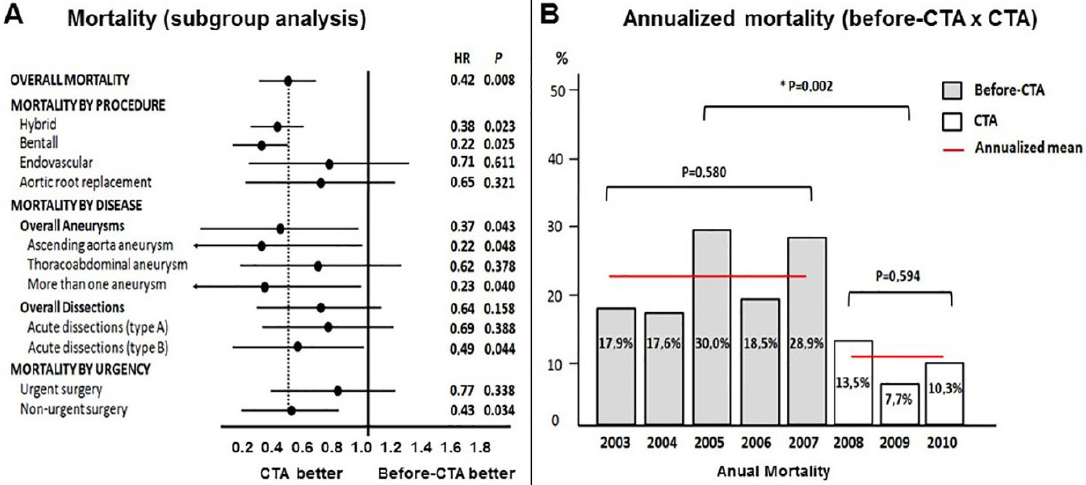
Fig. 3 - A) Subgroup analysis showing overall, procedure- disease-, and urgency-stratified mortality; B) Sensitivity analysis, comparing mortality by year in Before-CTA group, in CTA group, and mean annualized mortality between the 2